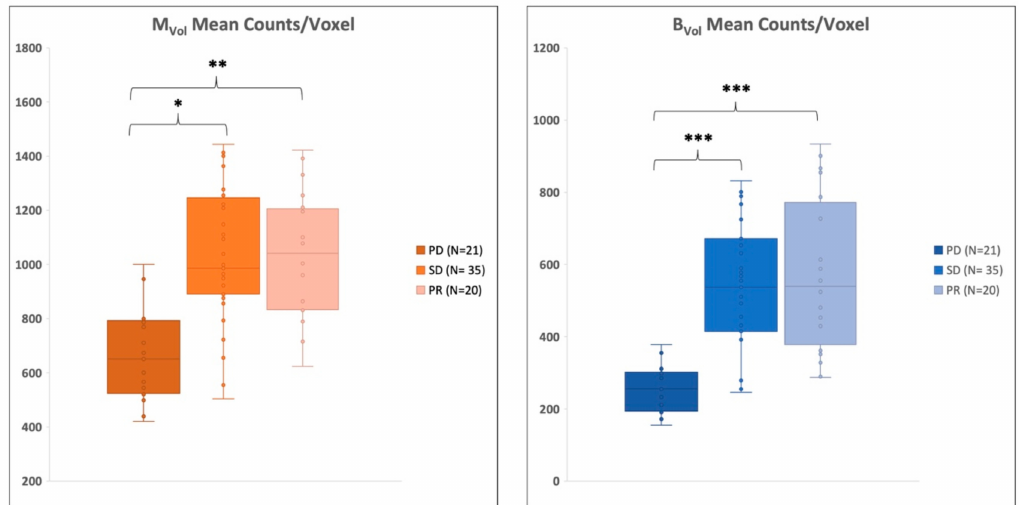
Figure 3. Radioactivity concentration according to response. Patients with progressive disease (PD) after the radioisotope therapy displayed a significantly lower radioactivity concentration at the baseline imaging in metastases volume (M Vol ) as well as in trabecular bone volume (B Vol ). * p < 0.05, ** p < 0.01, *** p < 0.001. SD = stable disease; PR = partial response.